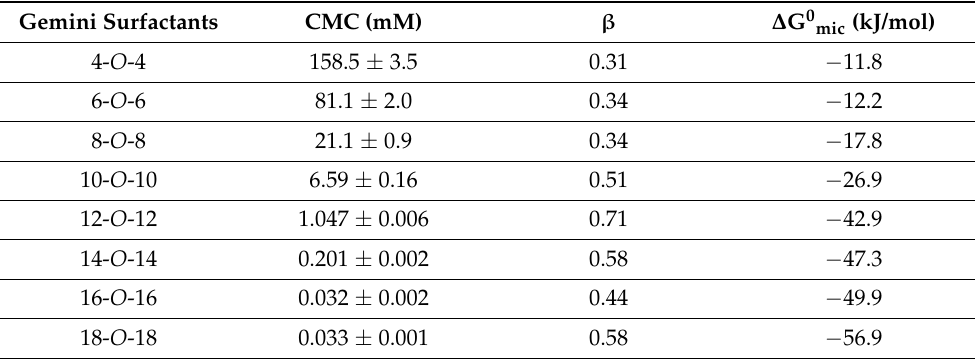
Table 3. Aggregation parameters for 3-oxa-1,5-pentane- bis ( N -alkyl- N , N -dimethylammonium bromides). Gemini